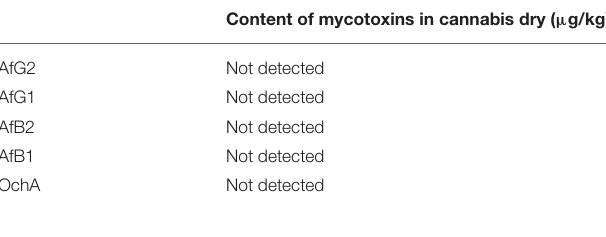
TABLE 6 | The content of Aflatoxin B1, B2, G1, G2, and Ochratoxin A in cannabis dry flower variety Herijuana Batch No. 01012101 before spike.